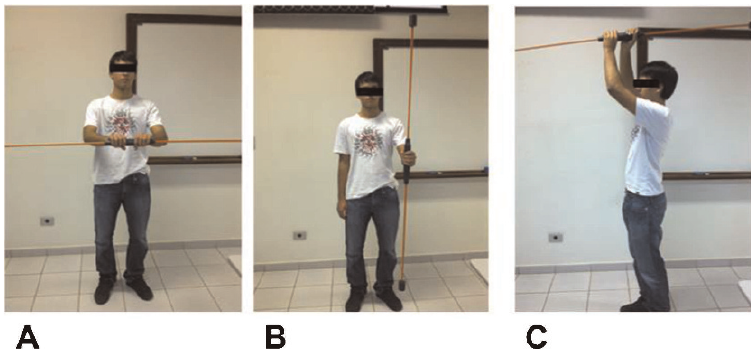
Figure 2 - Exercise protocol with flexible pole at the three positions: 1) with the shoulder on 90 ˚ of flexion with the flexible pole on the transverse plane (A); 2) with shoulders at approximately 180 ˚ of flexion with the flexible pole on the frontal plane, parallel to the ground (B); and 3) shoulders at 90 ˚ of flexion with the flexible pole on the sagittal plane, perpendicular to the ground (C).